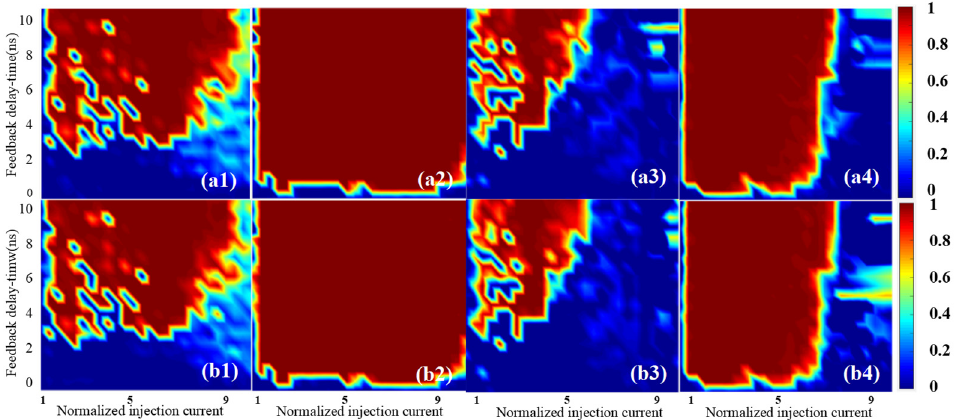
μ τ , ) plane. The Figure 2. The two-dimensional map of the 0–1 test for chaos of MSRL in the ( µ , τ f ) plane. (a1,a2,a3,a4): f